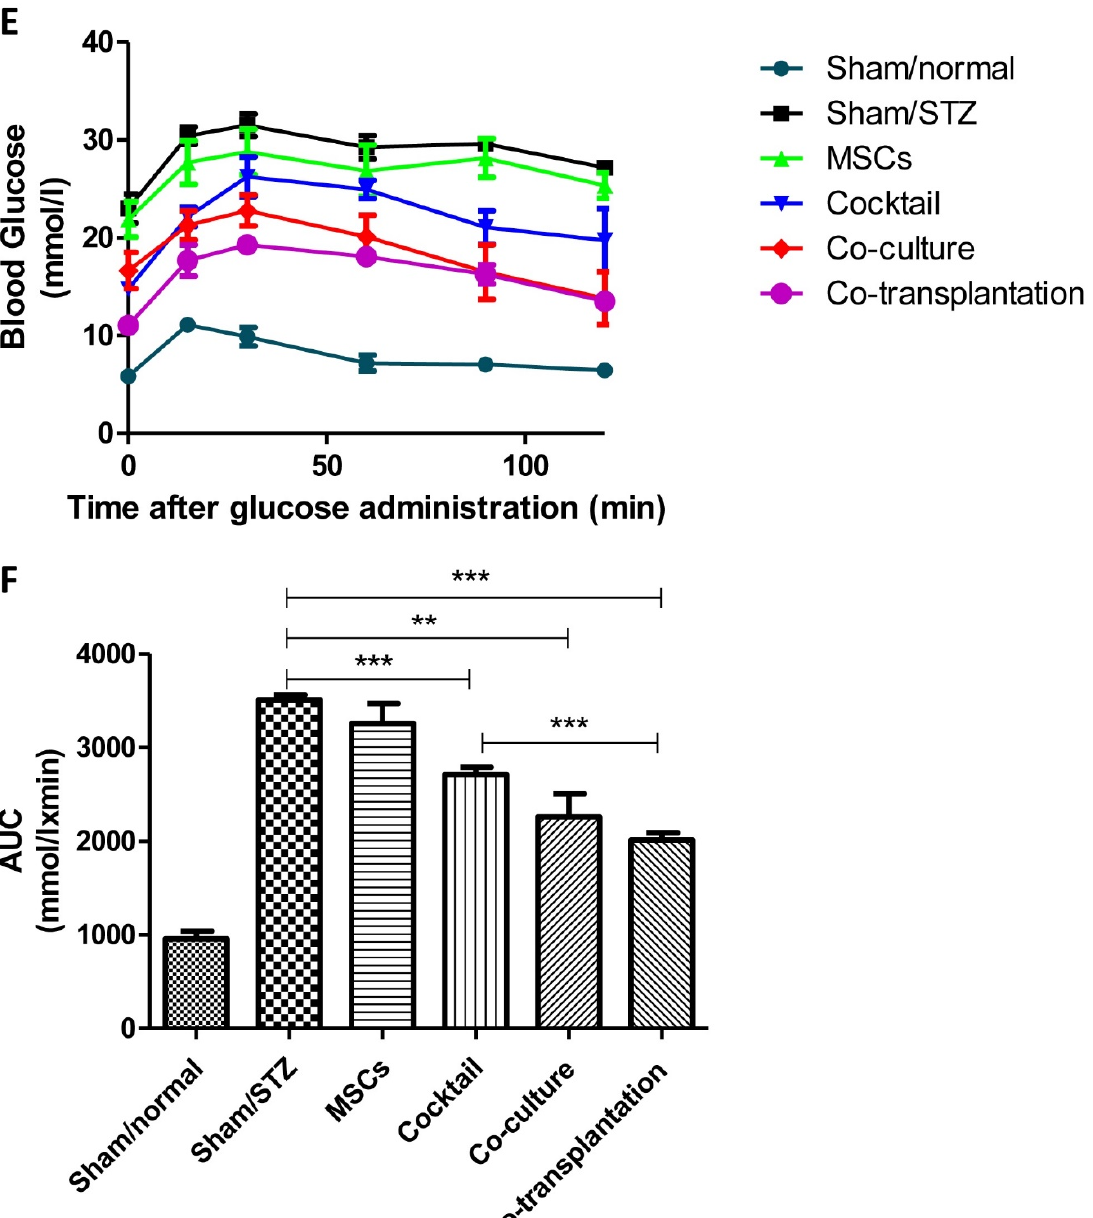
Figure 8. Promotion of in vivo functionality in ICC engraftment by MSC co-transplantation. ( A ) Assessment of insulin-positive pancreatic islets indicate the destruction of beta cells in nude mice with streptozocin (STZ) treatment 10 days post-transplantation. ( B ) Dashed areas represent the insulin-producing ICC engraftment in the kidney 10 days post-transplantation. The body weight ( C ) and blood glucose ( D ) were monitored every week. An intraperitoneal glucose tolerance test (IPGTT) (glucose, 1 mg / kg) ( E ) and AUCs ( F ) were conducted 1 month after transplantation. Insulin and DAPI staining were expressed in green and blue, respectively. Scale bar = 40 µ m. (n = 5 per group; * p < 0.05, ** p < 0.01, *** p < 0.001. All data are expressed as means ± SEM).